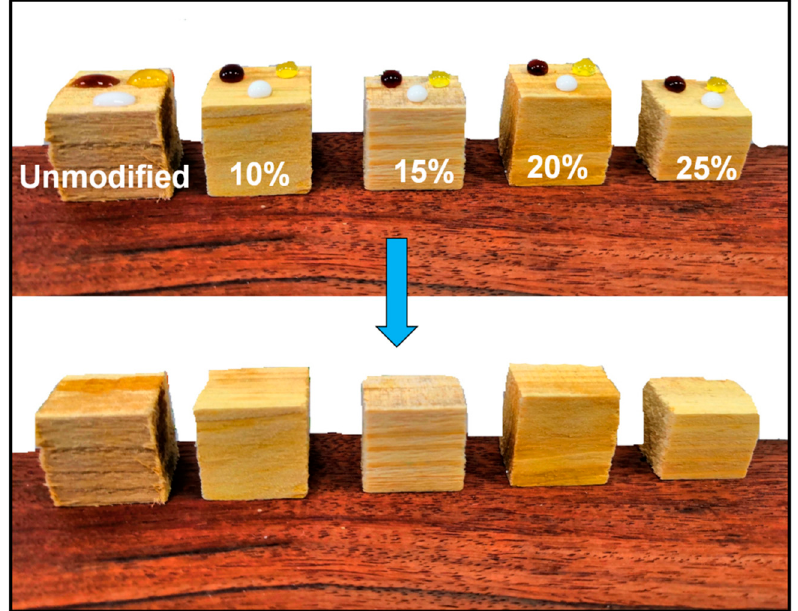
Figure 9. Anti-fouling property of untreated and D4H (different contents) treated woods to milk, soy sauce, and orange juice.